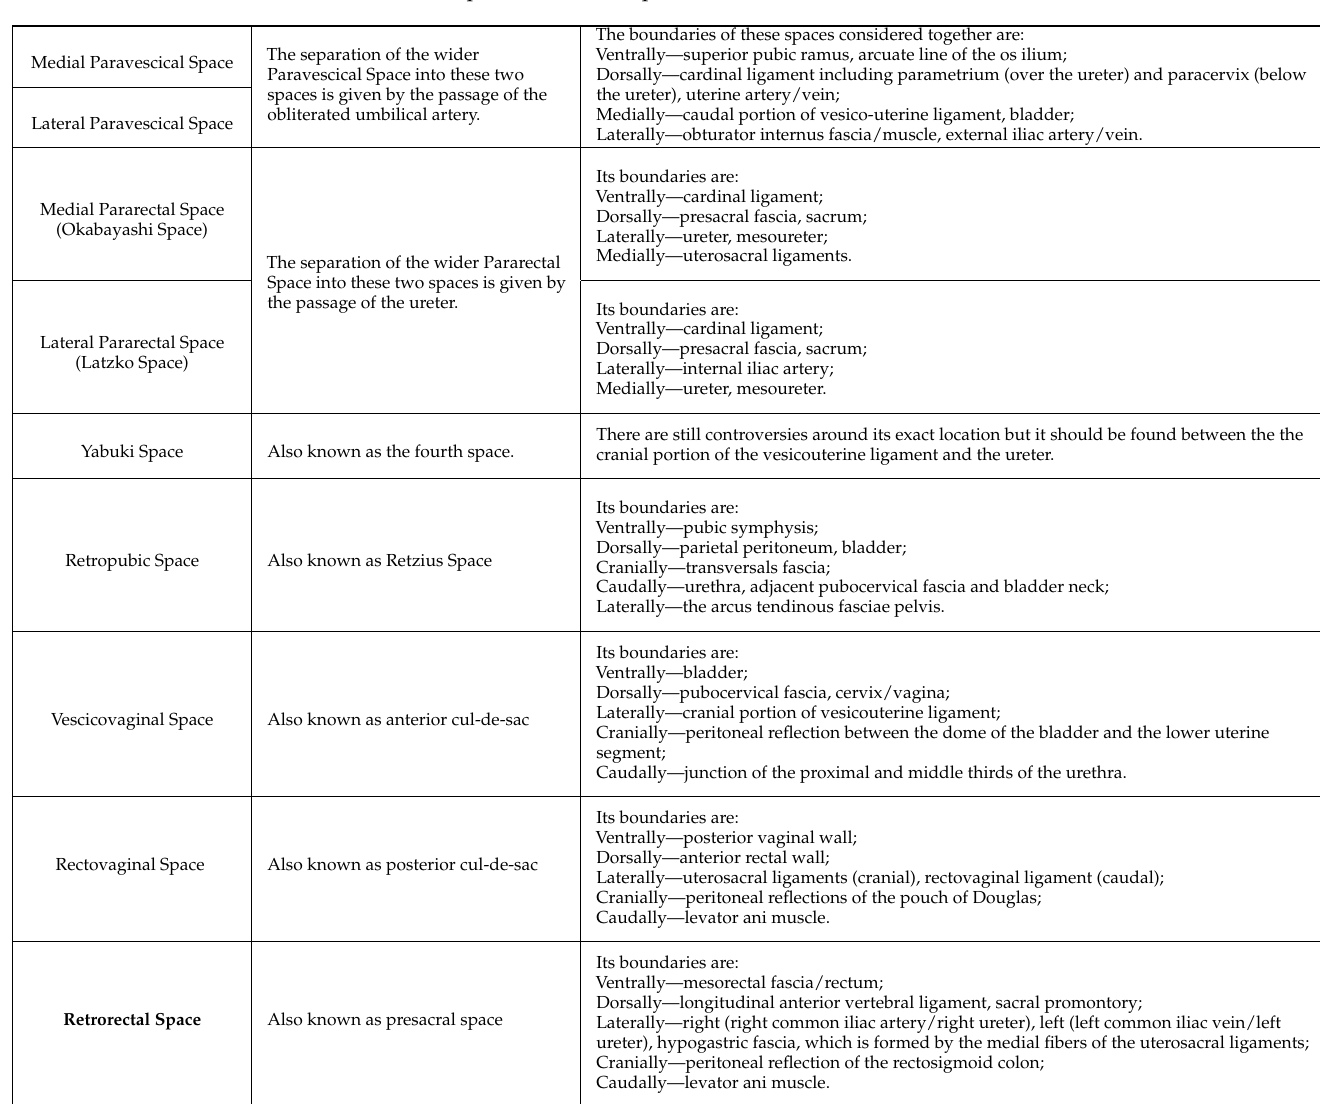
Table 1. The pelvic avascular spaces